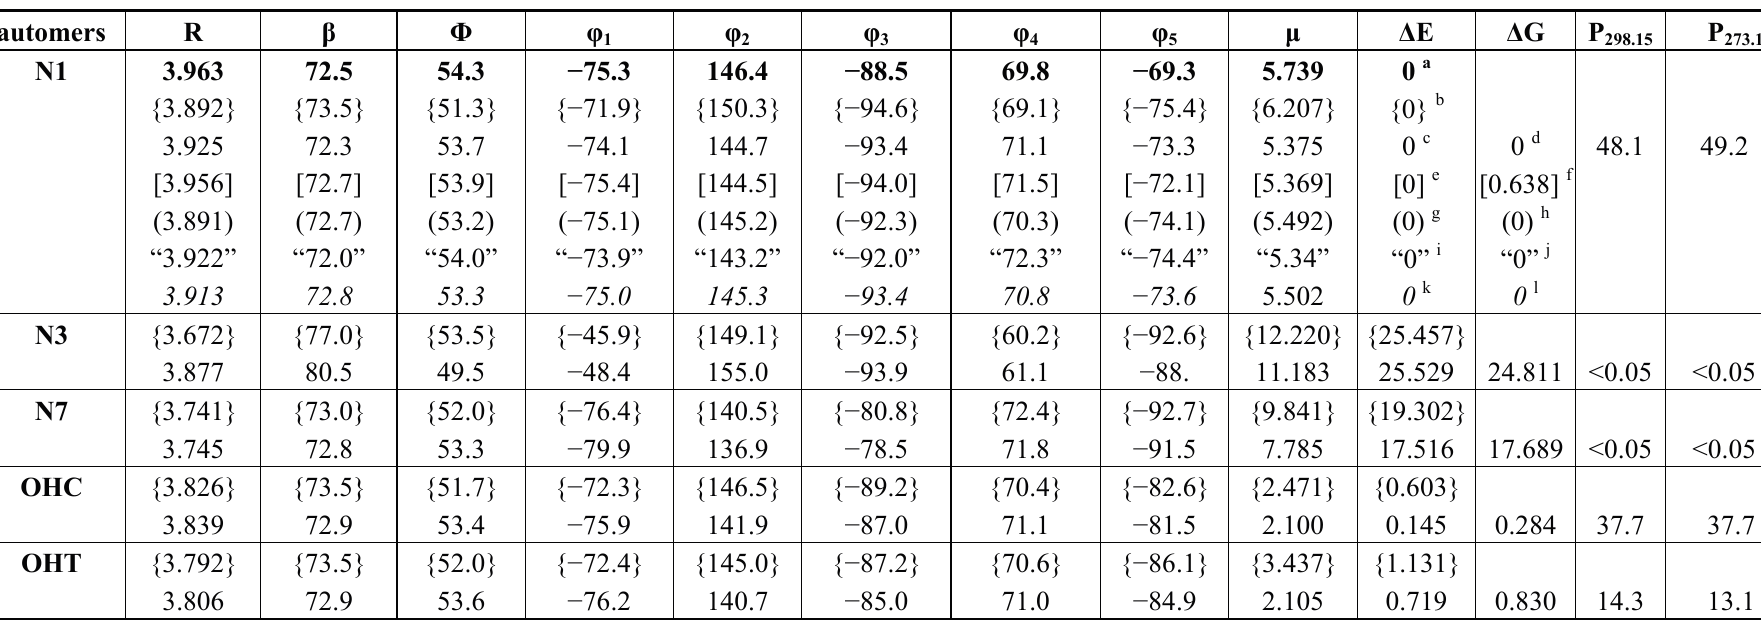
Table 1. The optimum stable tautomers calculated in acyclovir molecule at the levels: B3LYP/6-311++G(3df,pd) (values in bold); MP2/6-31G(d,p) (values in key); B3LYP/6-31G(d,p) (values in normal); O3LYP/6-31G(d,p) (values in brackets); B3PW91/6-31G(d,p) (values in parenthesis); B3LYP/cc-pVDZ (values in quotation marks) and B972/6-31G(d,p) (values in italic type). Torsional angles in